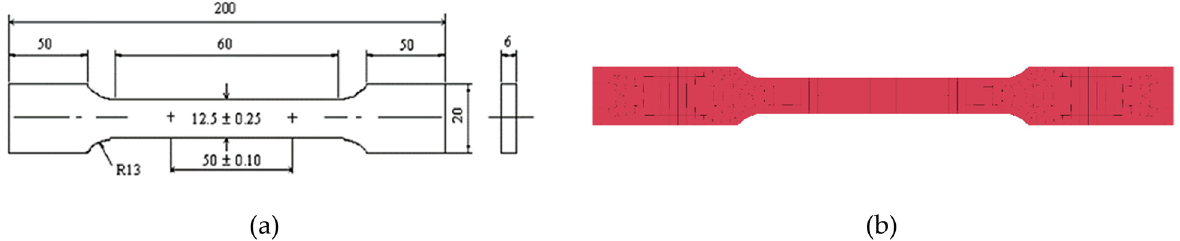
Figure 4: ( a ) Dimension of the tensile test specimen [ 17 ] . ( b ) Finite element of the